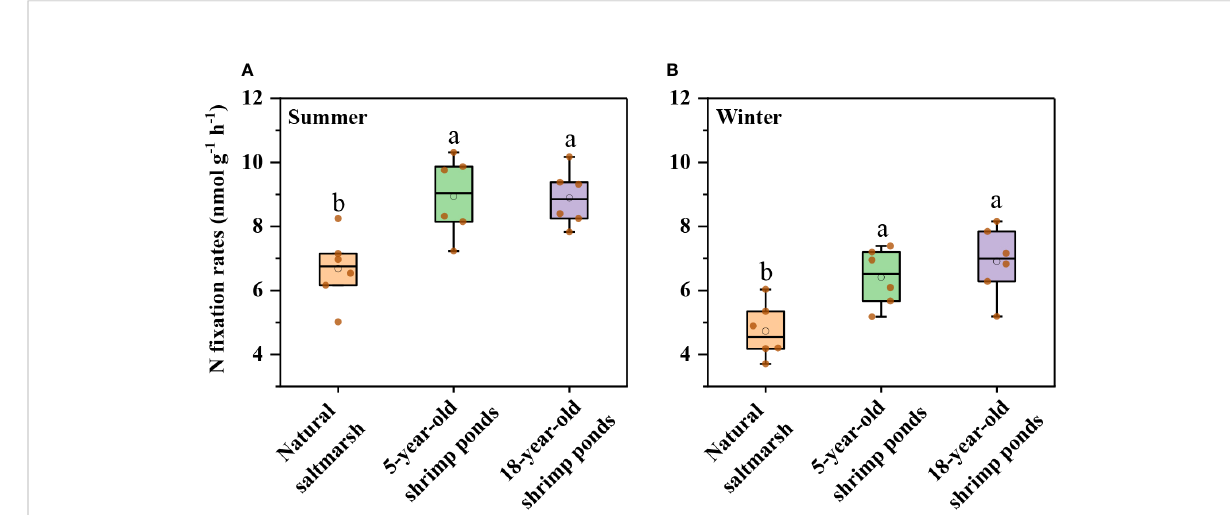
FIGURE 3 Sediment N fi xations rates of natural saltmarsh and shrimp ponds in (A) Summer and (B) Winter. Different lowercase letters indicate signi fi cant differences (p < 0.05) among natural saltmarsh and shrimp ponds in the same